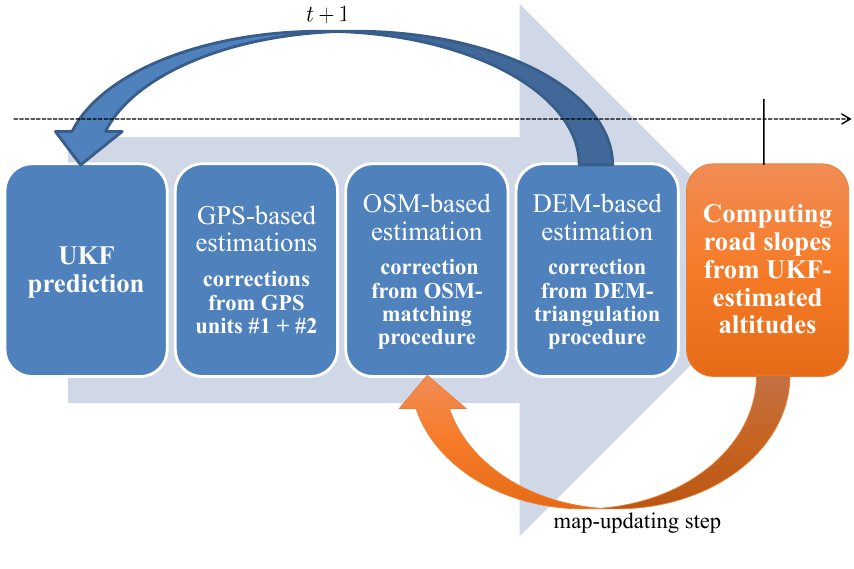
Figure 1. Multisensor fusion